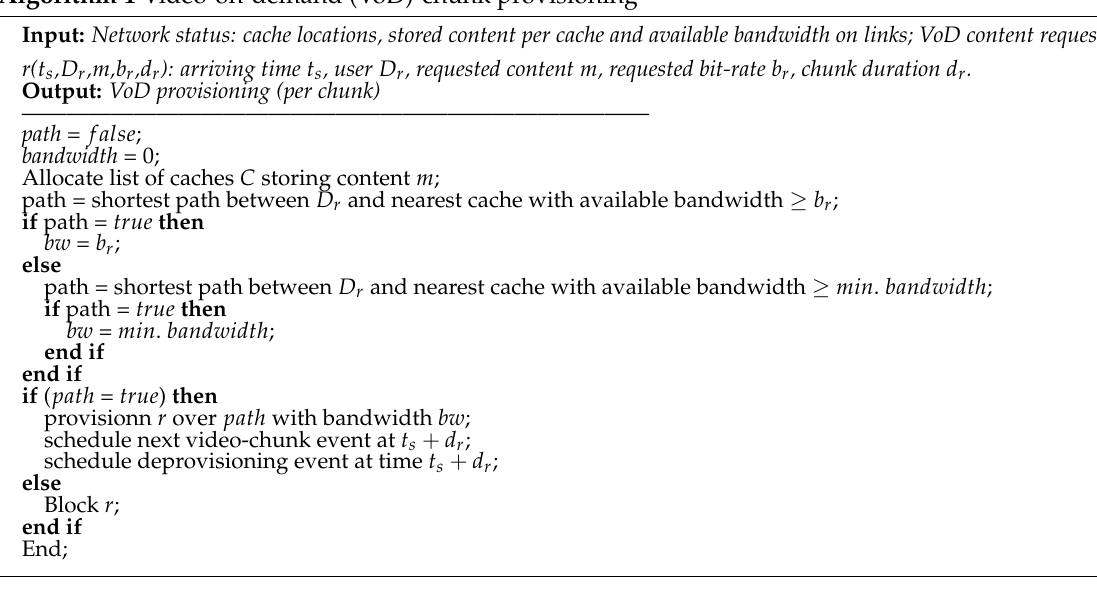
Algorithm 1 Video-on-demand (VoD)-chunk provisioning